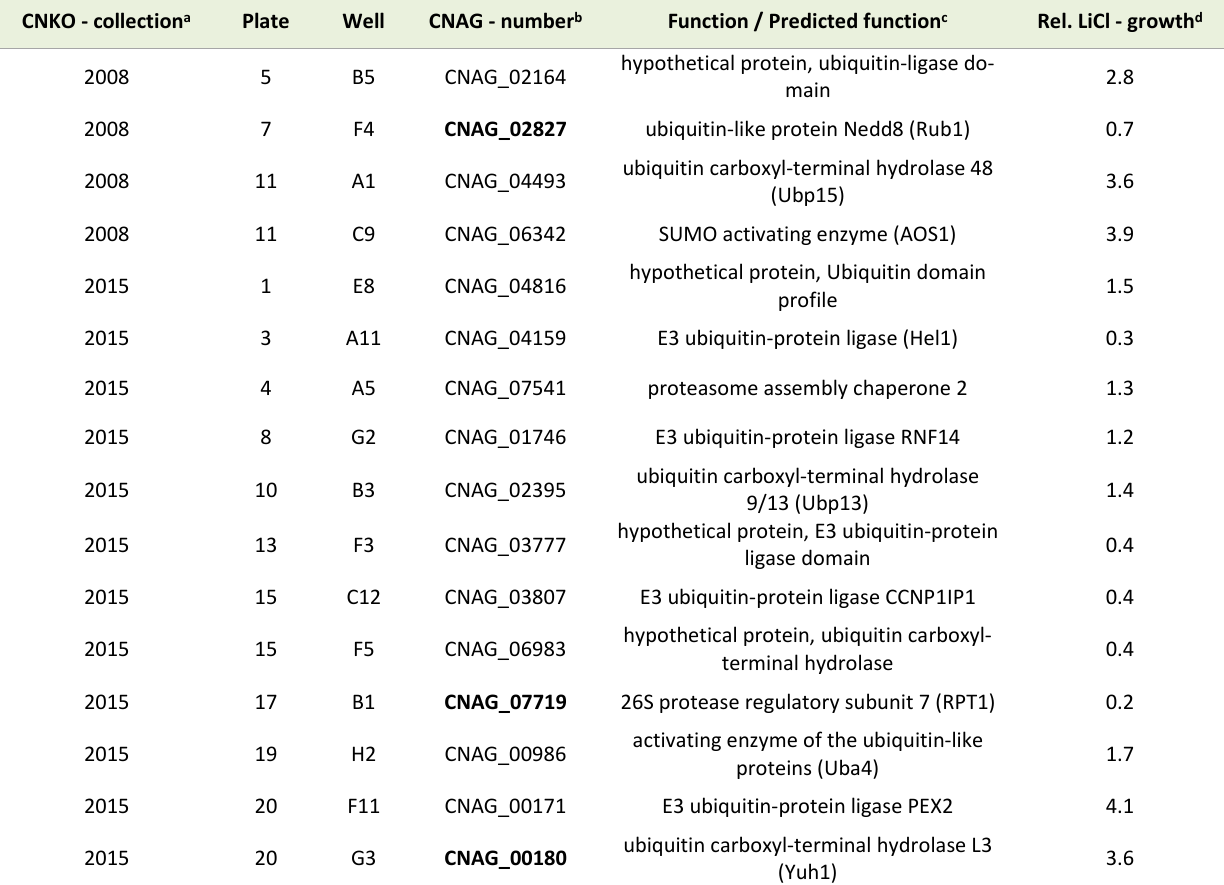
TABLE 1. Ubiquitin/proteasome-associated mutants with altered growth in presence of lithium. CNKO - collection